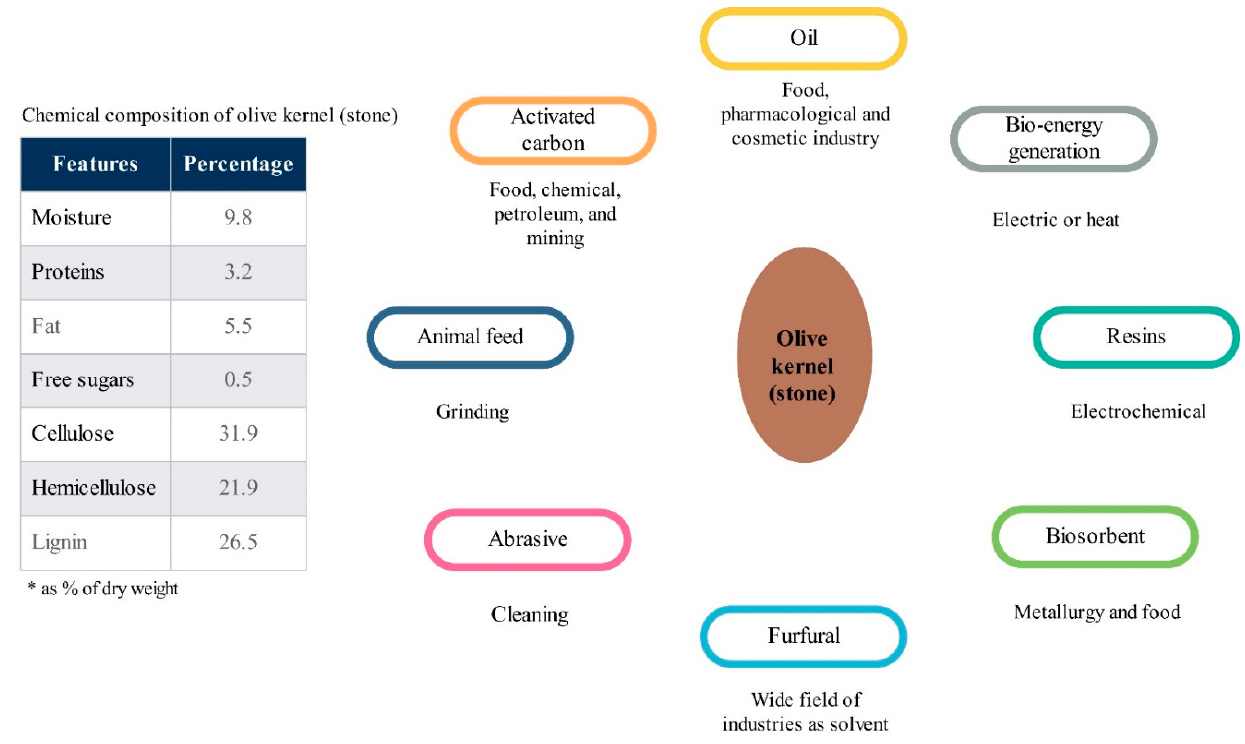
Figure 1. Characterization and application of olive kernel [37].